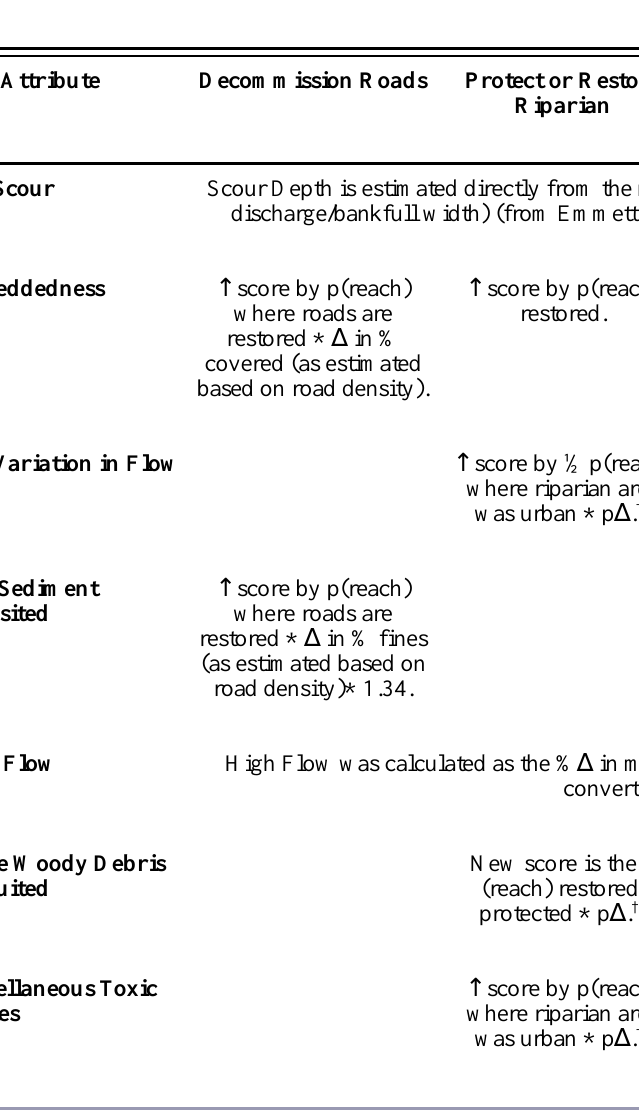
Table A3. Model used to translate conservation actions in management strategies into data in a format ready to be used as inputs by the Ecosystem Diagnosis and Treatment (EDT) model. All actions were subject to 4 constraints: (1) the proportion of each EDT reach affected by a strategy was equal to the proportion of affected SSHIAP reaches comprising an EDT reach; (2) new EDT scores affected by conservation actions were constrained between patient and template scores and trended toward the